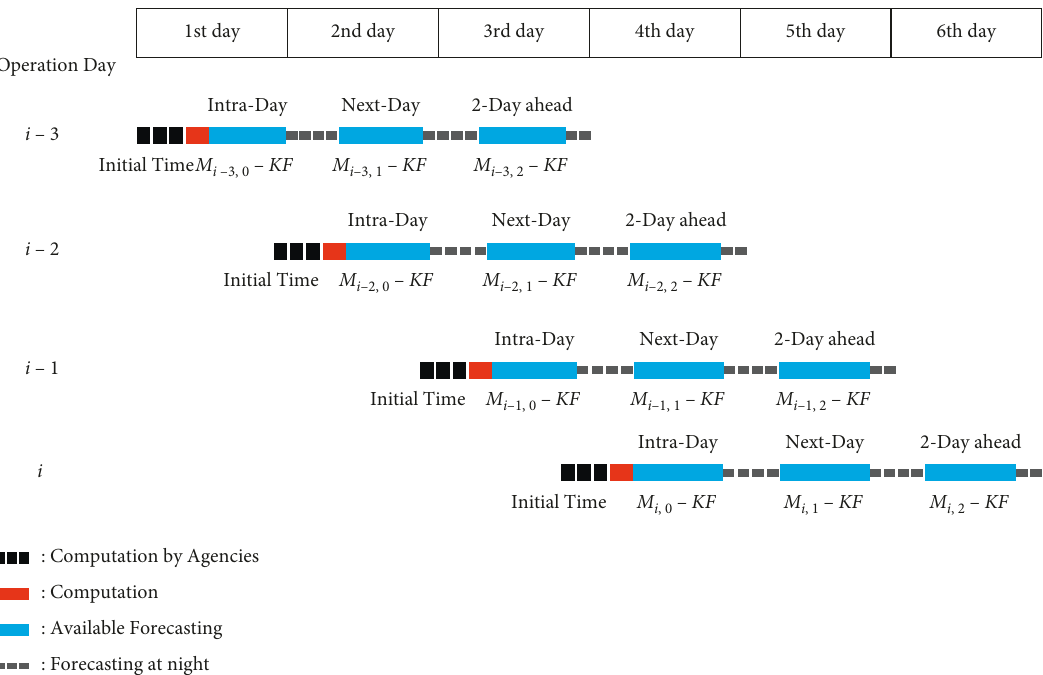
Figure 6: Results of intraday prediction of the solar GHI (global horizontal irradiance) by using WRF only M − KF and observed one during the period from July 11 to 20 in 2013. Kalman filter M i, 0